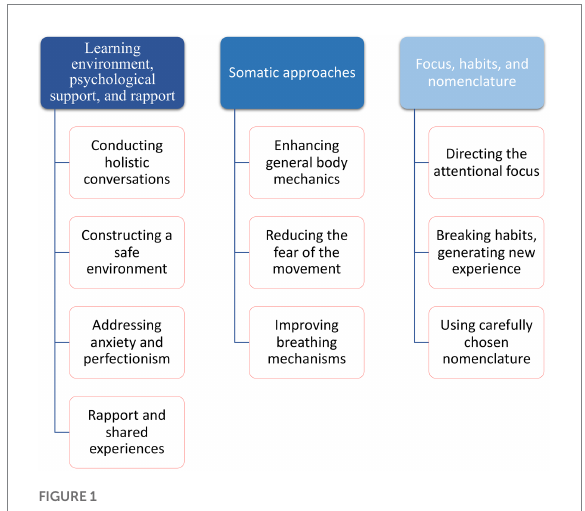
FIGURE 1 Strategies for addressing non-motor